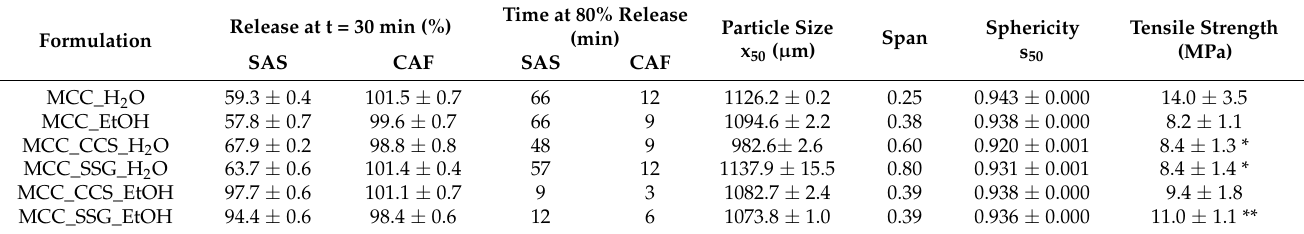
Table 2. Characteristics of the pellet formulations (mean ± SD, n = 3, except tensile strength were n = 6).